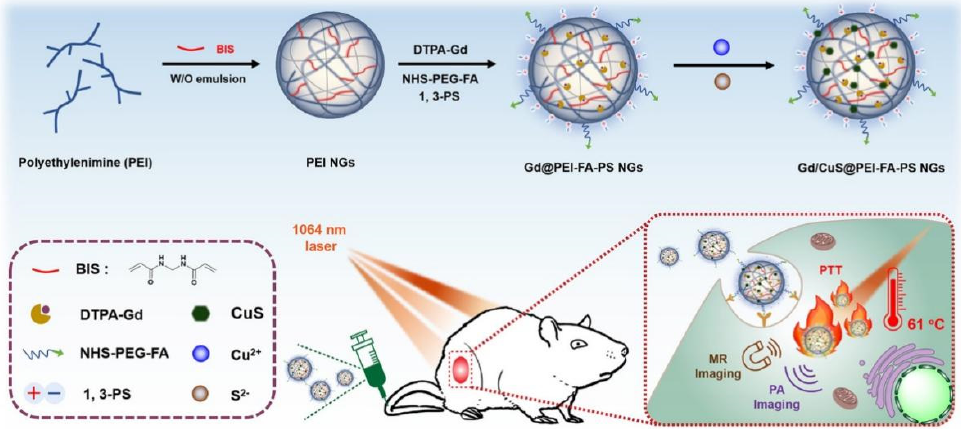
Figure 3. Schematic illustration of the synthesis of the PEI nanogel platform for tumor-targeted PTT. Reprinted with permission from [152]. Copyright 2023 American Chemical Society.